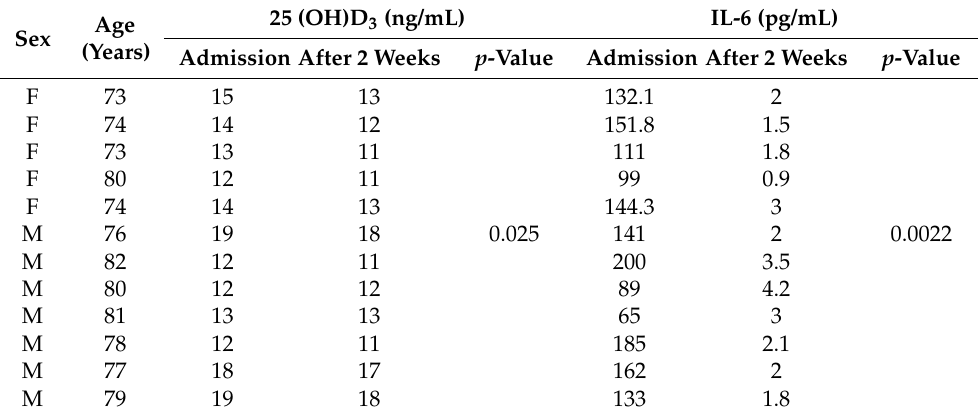
Table 2. Serum levels of 25(OH)D 3 (normal values >30 ng/mL) and IL-6 (normal values <6